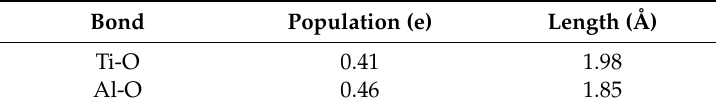
Table 3. Mulliken populations of bonds in Al 2 TiO 5